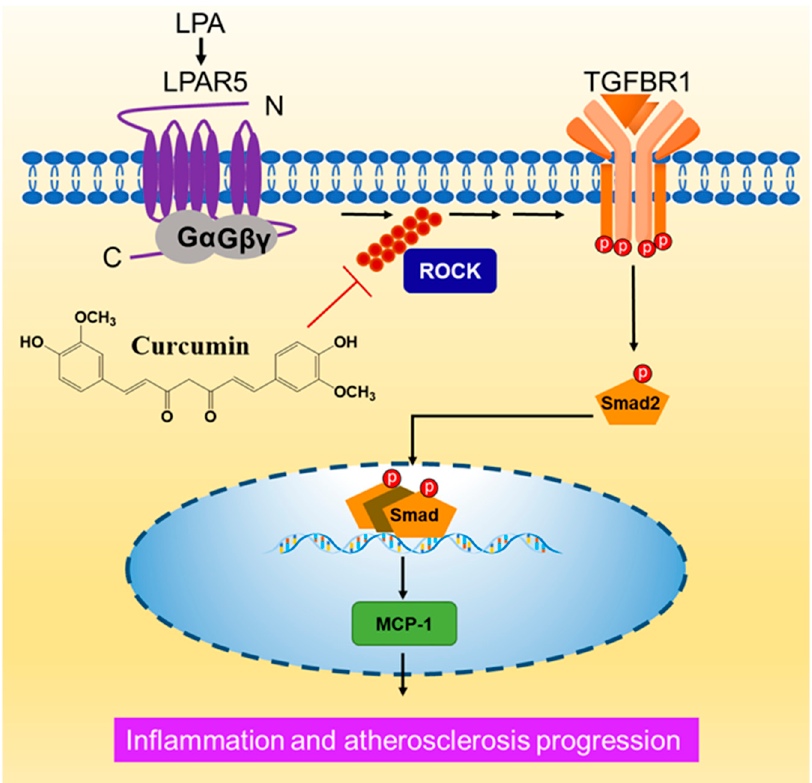
Figure 7. A schematic showing the mechanism of curcumin inhibiting of LPA mediated MCP-1 expression. In VSMCs, LPA via LPAR5 transactivates the TGFBR1 in a ROCK dependent manner. LPA mediated MCP-1 expression is regulated by the TGFBR1 transactivation pathway. Curcumin blocks LPA mediated TGFBR1 transactivation and MCP-1 expression via inhibiting ROCK signalling.